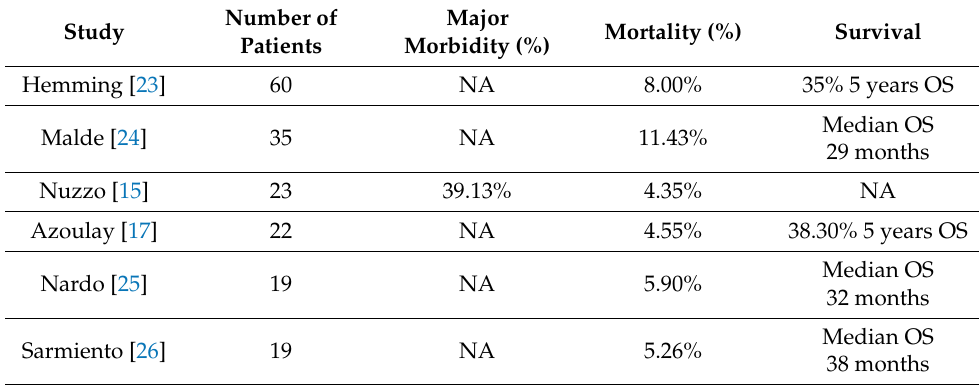
Table 1. Major studies on IVC